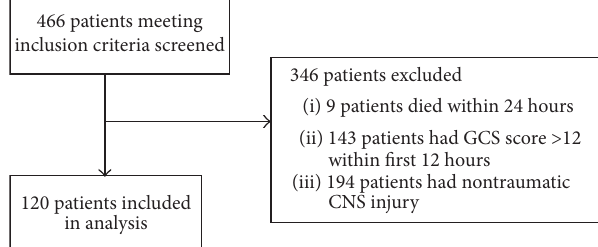
Figure 1: Total number of patients screened and included into the study. TBI: traumatic brain injury. GCS: Glasgow Coma Scale. CNS: central nervous